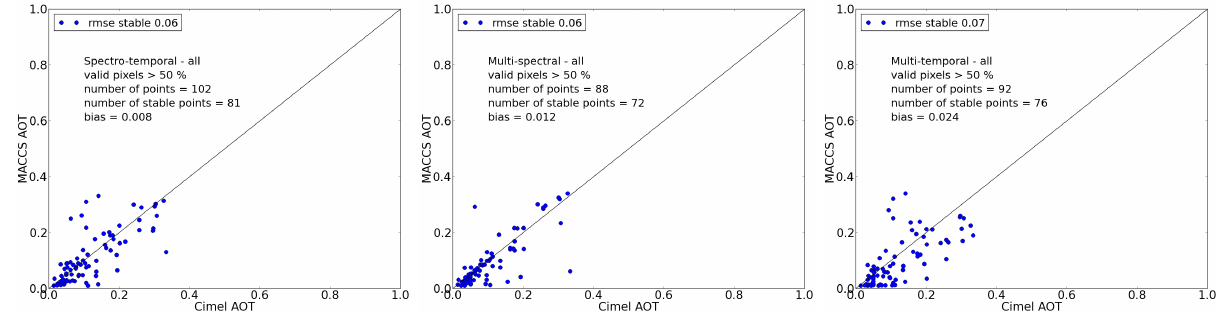
Figure 11. Comparison of AOT estimates from Formosat-2 at 550 nm obtained for all sites from the hybrid method (left), the multi-spectral method (middle) and the multi-temporal method (right), in stable cases.